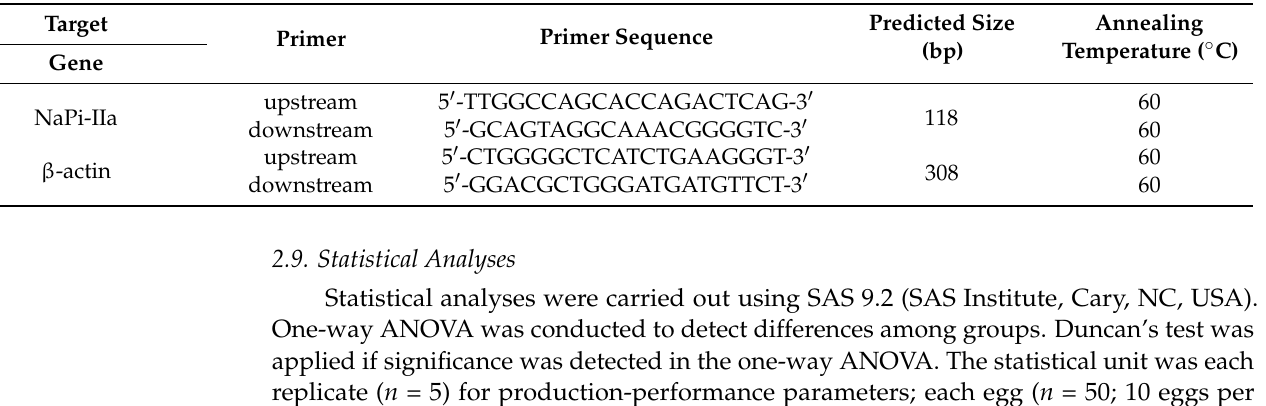
Table 3. Primer sequences used for real-time